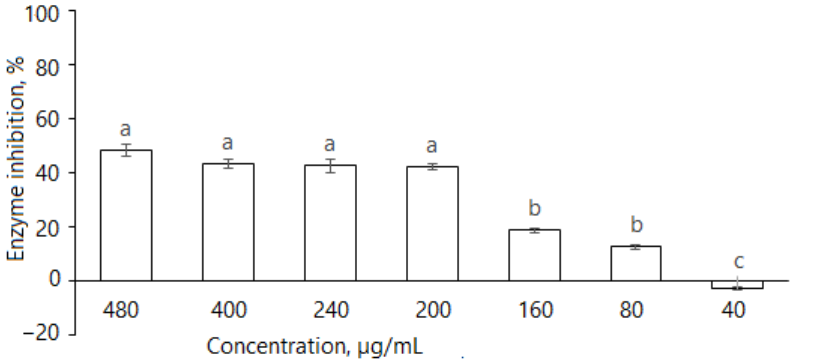
Figure 4. Inhibition of α -amylase by D. caucasica 70% ethanol leaf extracts at different concen- trations (enzyme activity in the absence of extract was considered as 100%). The values are the means ± standard error (SE) ( n = 3); different letters indicate that the values are significantly differ- ent, according to Fisher’s LSD test ( p < 0.05) after one-way ANOVA.